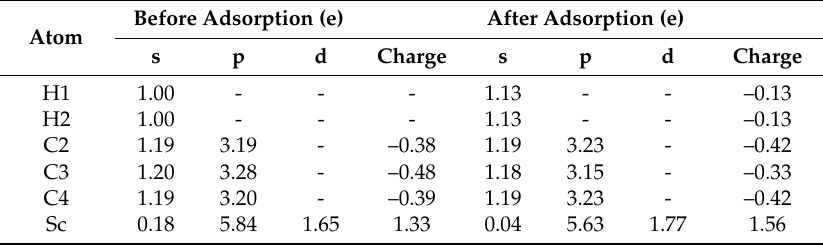
Table 2. Mulliken population analysis of the Sc-PG system before and after one H 2 molecule adsorption.